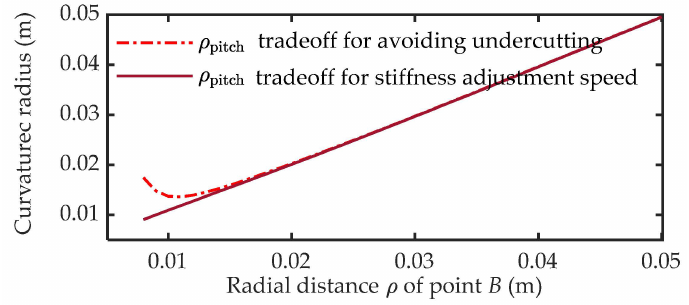
Figure 7. Curvature radius result after tradeoff